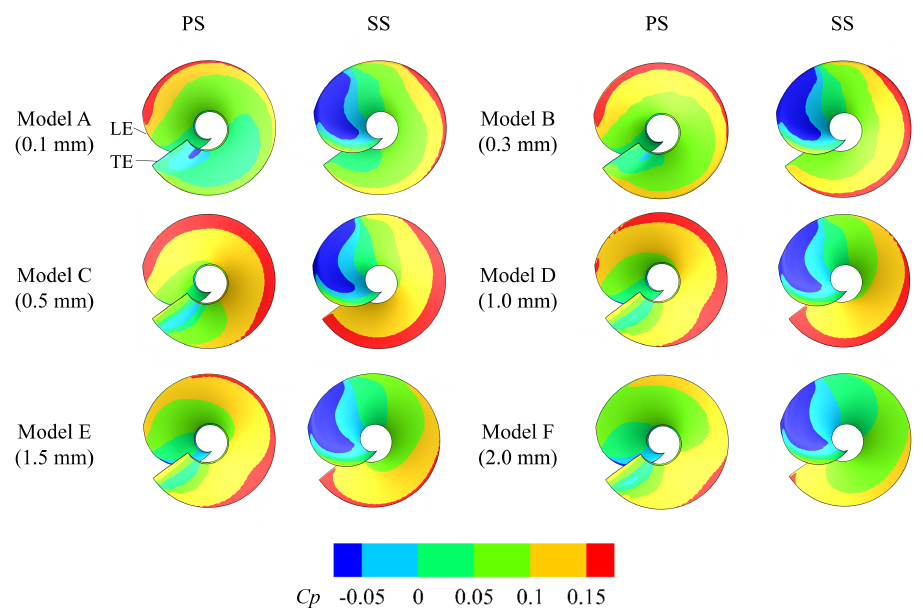
Figure 11. Loading at one certain blade for all models. LE: leading edge; TE: trailing edge; PS: pressure side; SS: suction